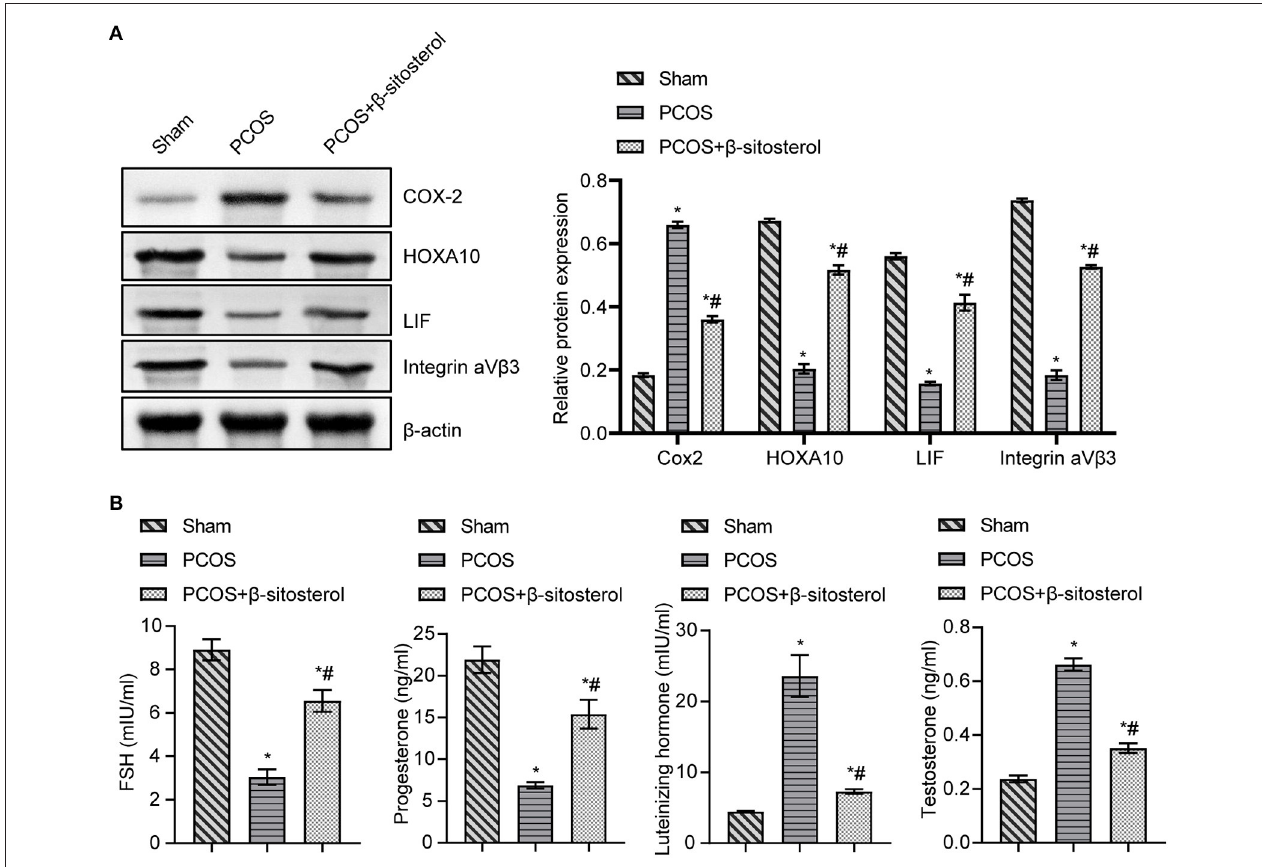
FIGURE 3 | Effect of β -sitosterol on the expression of endometrium receptivity markers and related hormones in PCOS-like mice. (A) Expressions of COX-2, HOXA10, LIF, and Integrin ανβ 3 in the endometrium of mice in each group were detected by western blot. (B) Levels of FSH, P, LH, and T in the serum of mice in each group were detected by ELISA. Data are presented as mean ± SEM. * P < 0.05 vs. Sham. # P < 0.05 vs. PCOS. FSH, follicle-stimulating hormone; P, progesterone; LH, luteinizing hormone; T, testosterone; PCOS, polycystic ovary